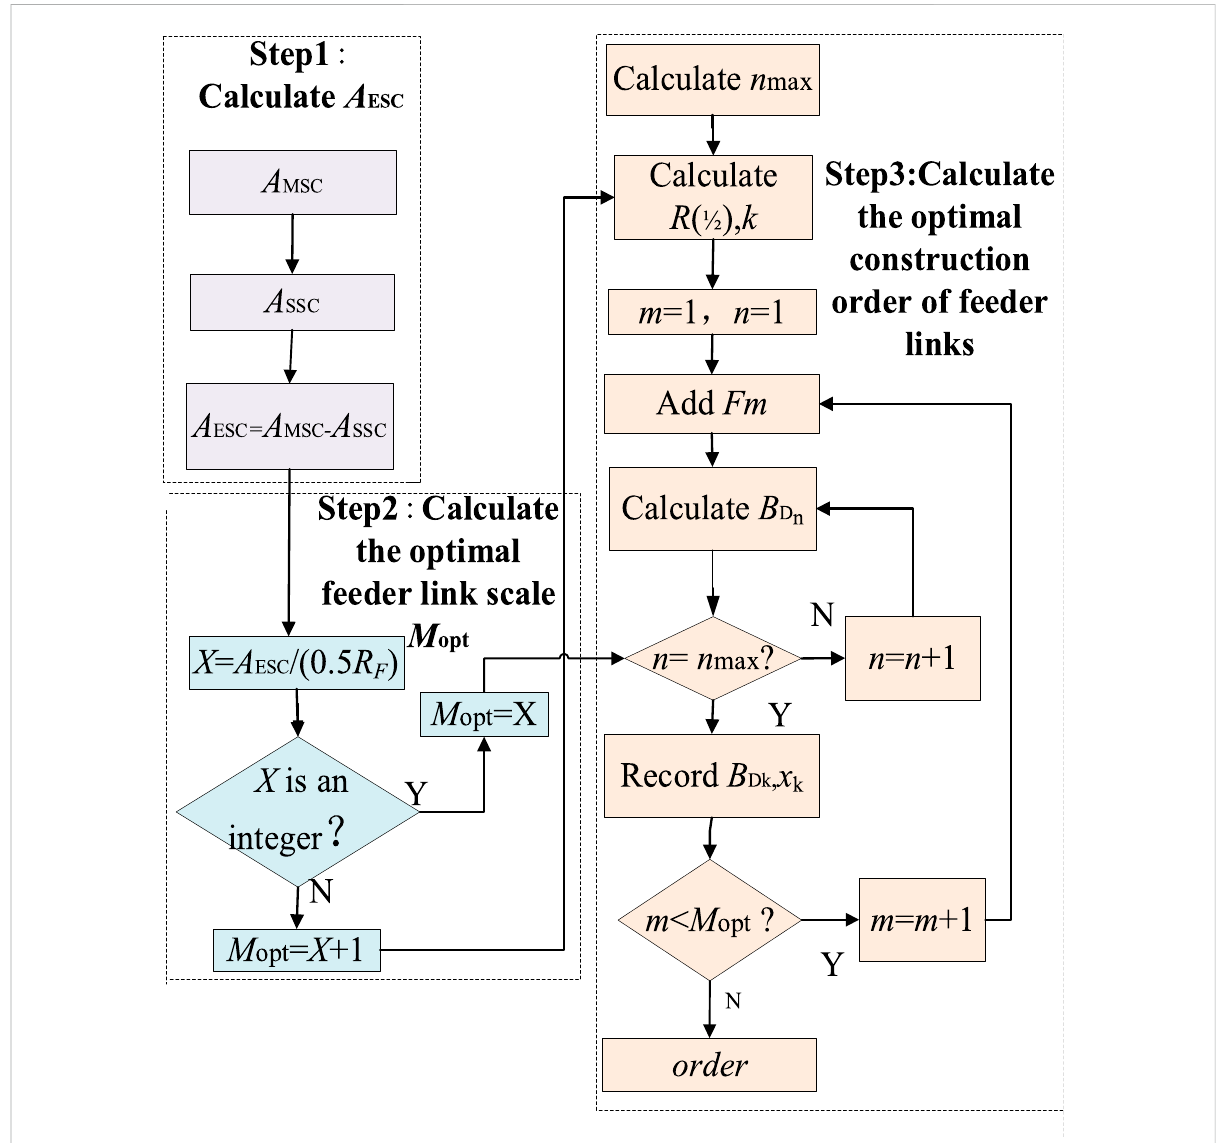
FIGURE 6 Flow chart of the algorithm to the optimal construction order of feeder